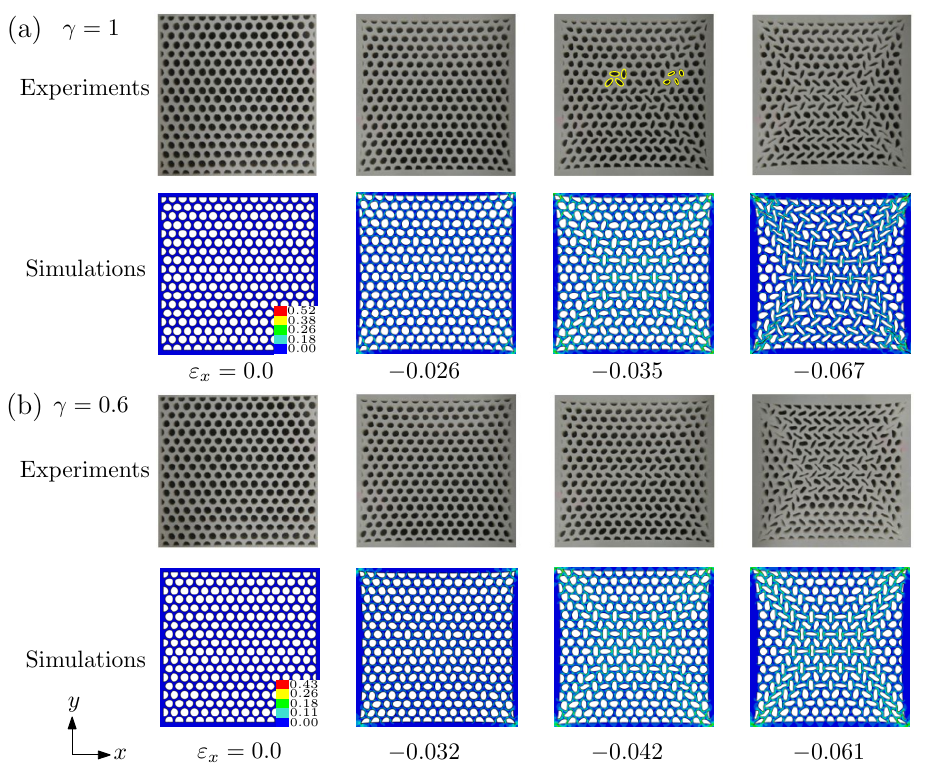
Figure 4. Deformed morphologies of specimen 1 at different applied strains predicted by the simulations and the experiments. The color bar shows the effective strain of the simulations. ( a ) γ = 1; ( b ) γ =